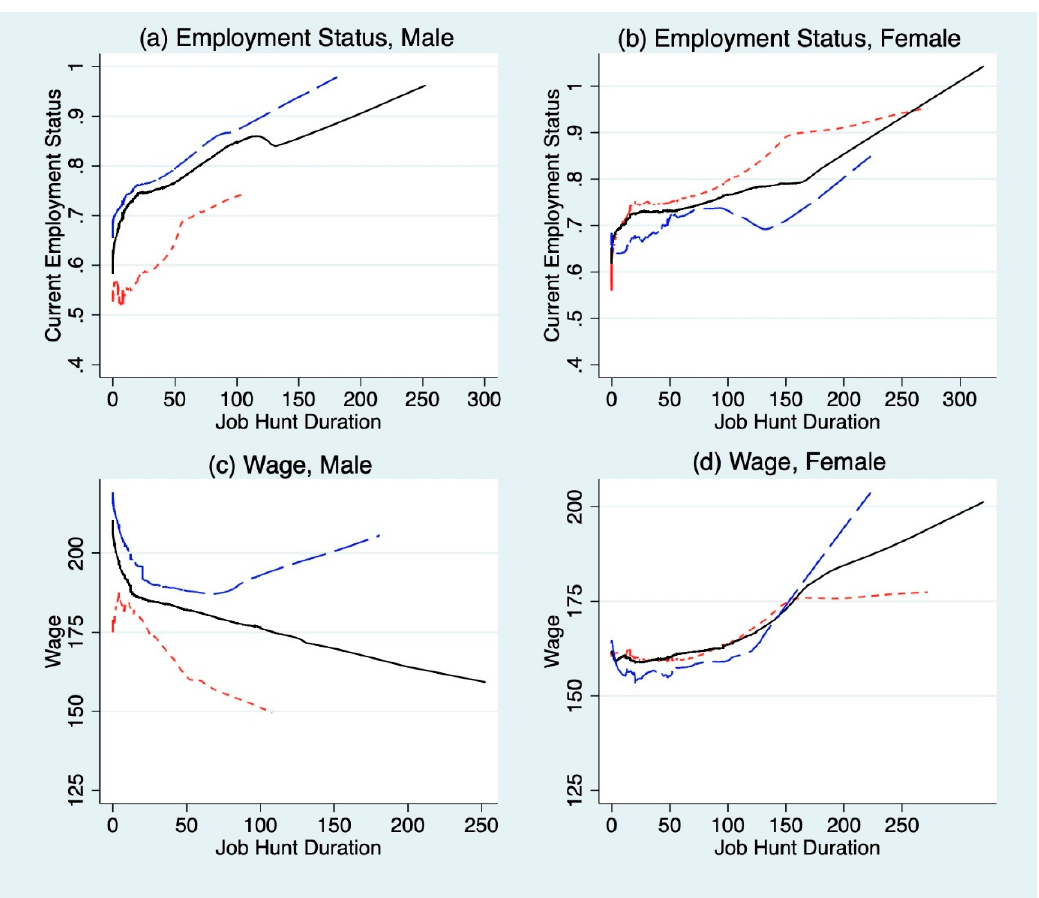
Figure 2. Lowest curves for each dependent variable (current employment status and wage) and job hunt duration by gender and BMI classification group. Note: The X-axis represents job hunt duration, which is measured in weeks. The Y-axis for ( a , b ) represents current employment status, while that of ( c , d ) represents wage in KRW in units of ten thousand. The solid black lines represent the normal-weight BMI group, the blue dashed lines represent the overweight and obese category, and the red dashed lines represent the underweight individuals.